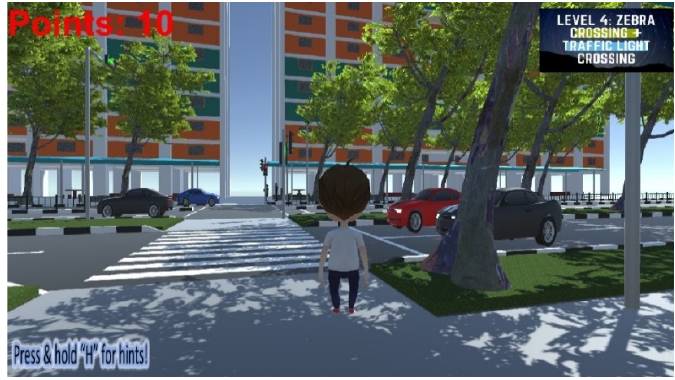
Figure 10. Example game scene at Level 4 in the Play mode.